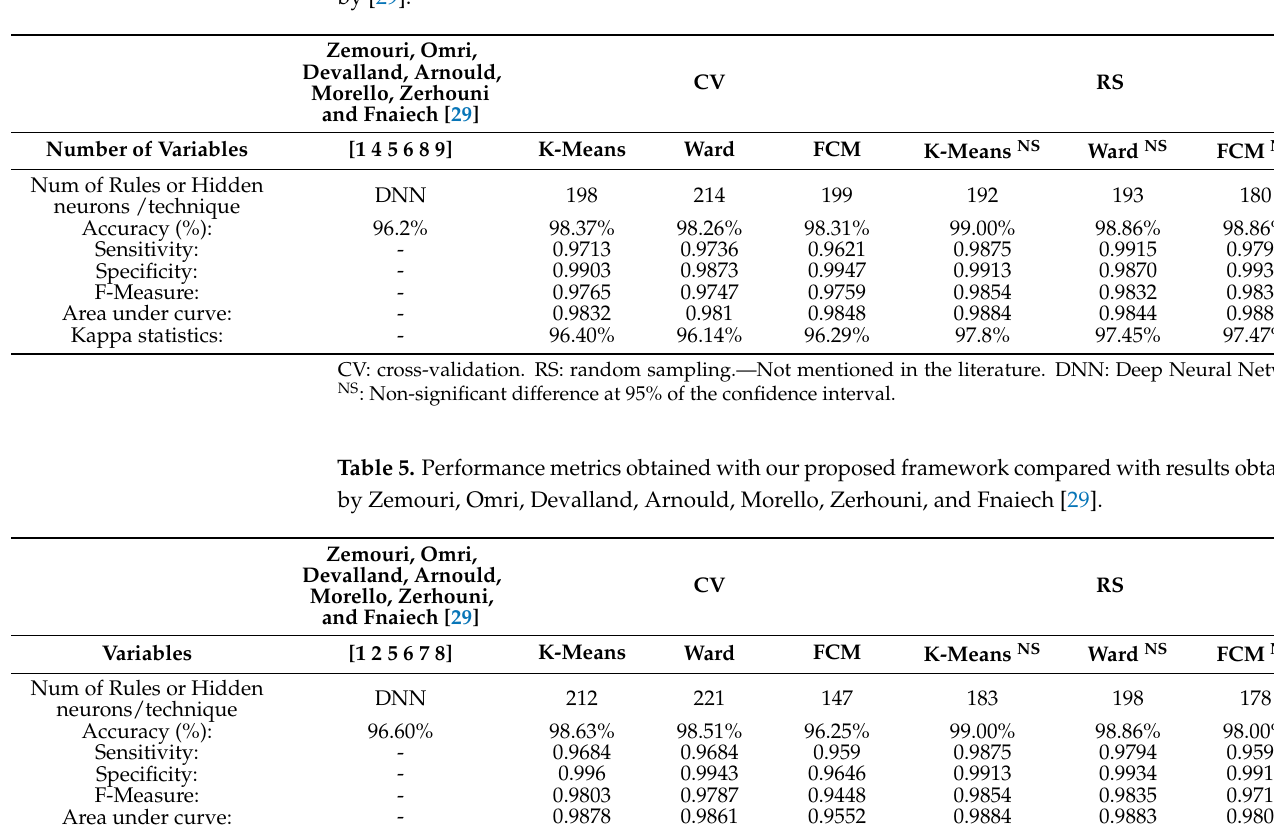
Table 4. Performance metrics obtained with our proposed framework compared with results obtained by [29].